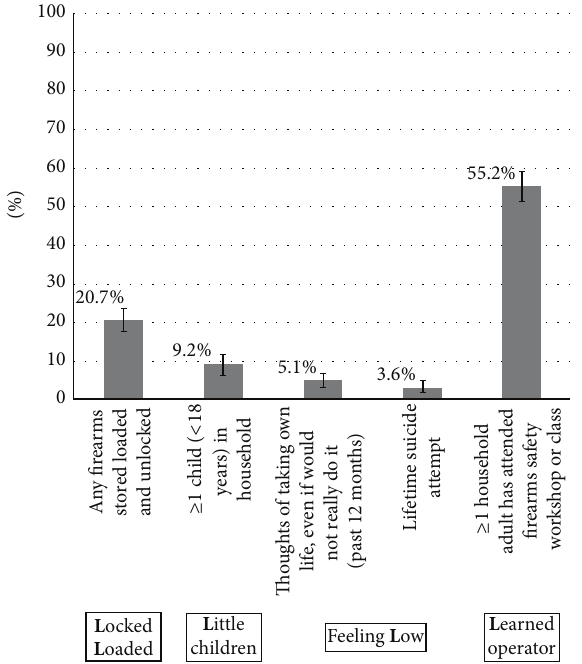
Figure 2: Gun safety practices among older adults with ≥ 1 gun at home. Weighted prevalence of the 5 Ls framework for gun safety among older adult gun owners ( 𝑁 = 987 ). Error bars represent 95% Confidence